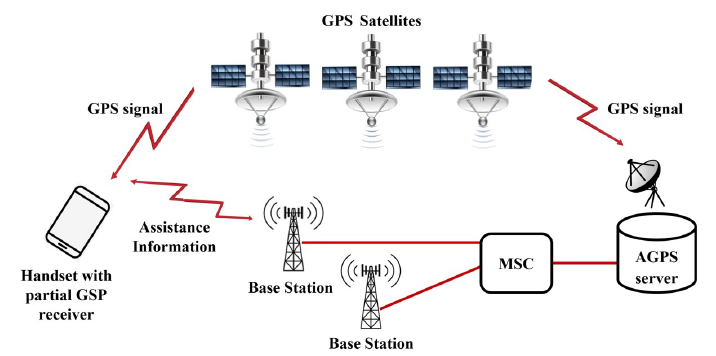
Figure 12. Assisted GPS (AGPS), reproduced with permission from Djuknic, Geolocation and Assisted GPS, published by IEEE,